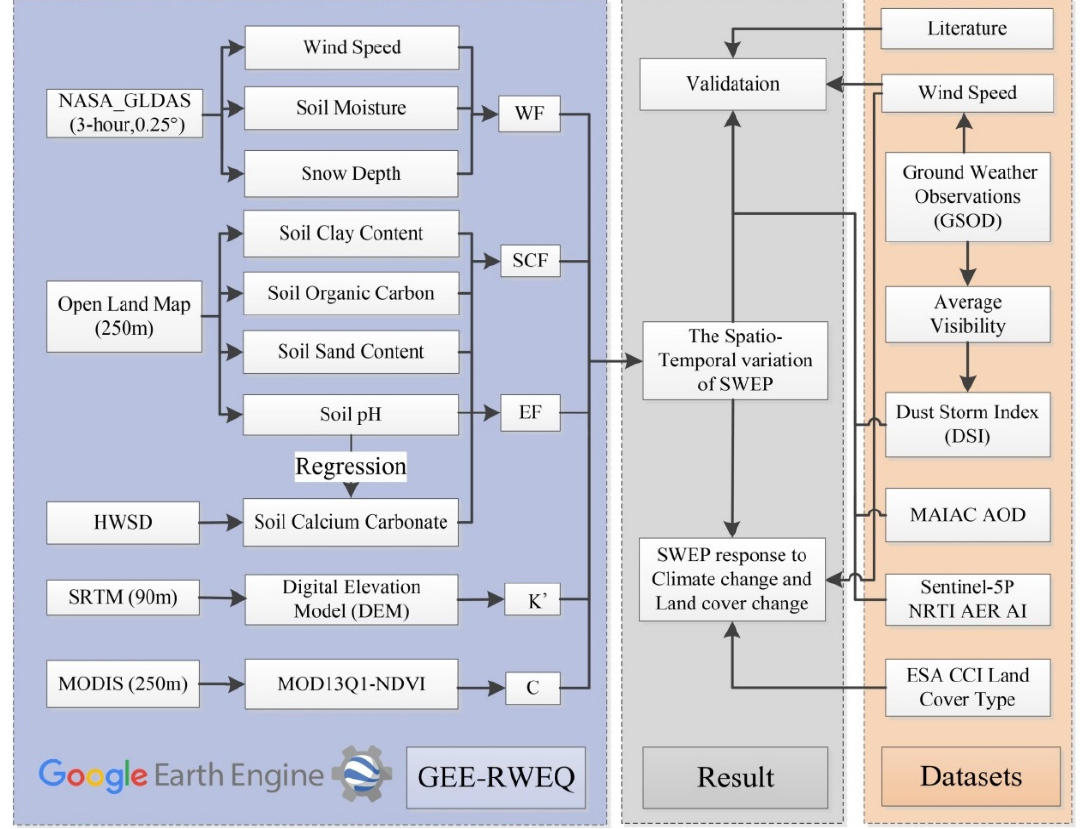
Figure 2. The technical flowchart of this study.